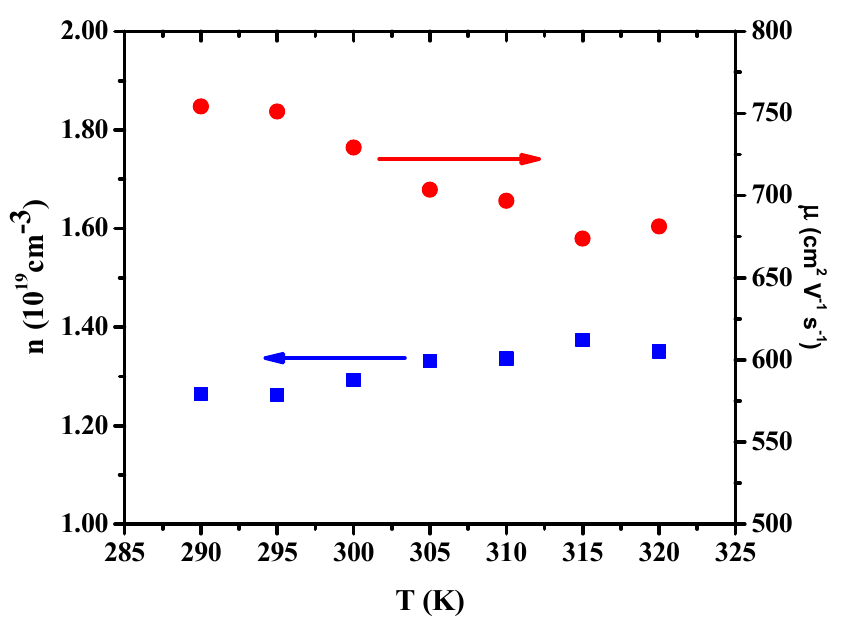
Figure 4. Temperature dependence of carrier concentration and carrier mobility for Bi 2 Se 3 NW.